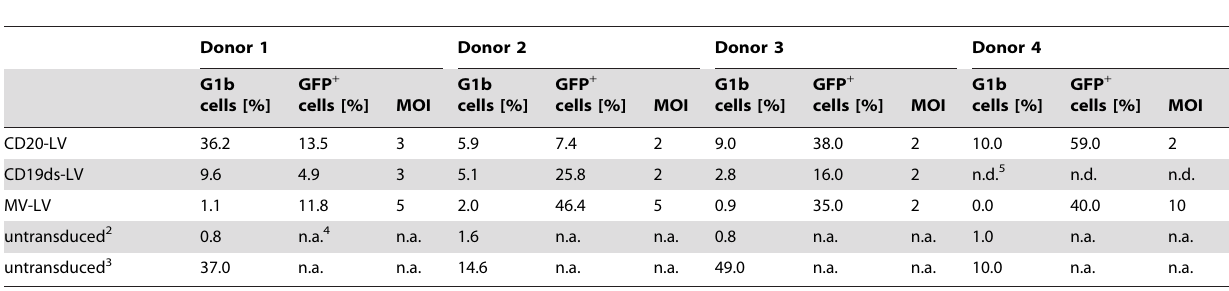
Table 1. Cell cycle progression of resting primary human B lymphocytes after transduction with targeted vectors. 1.